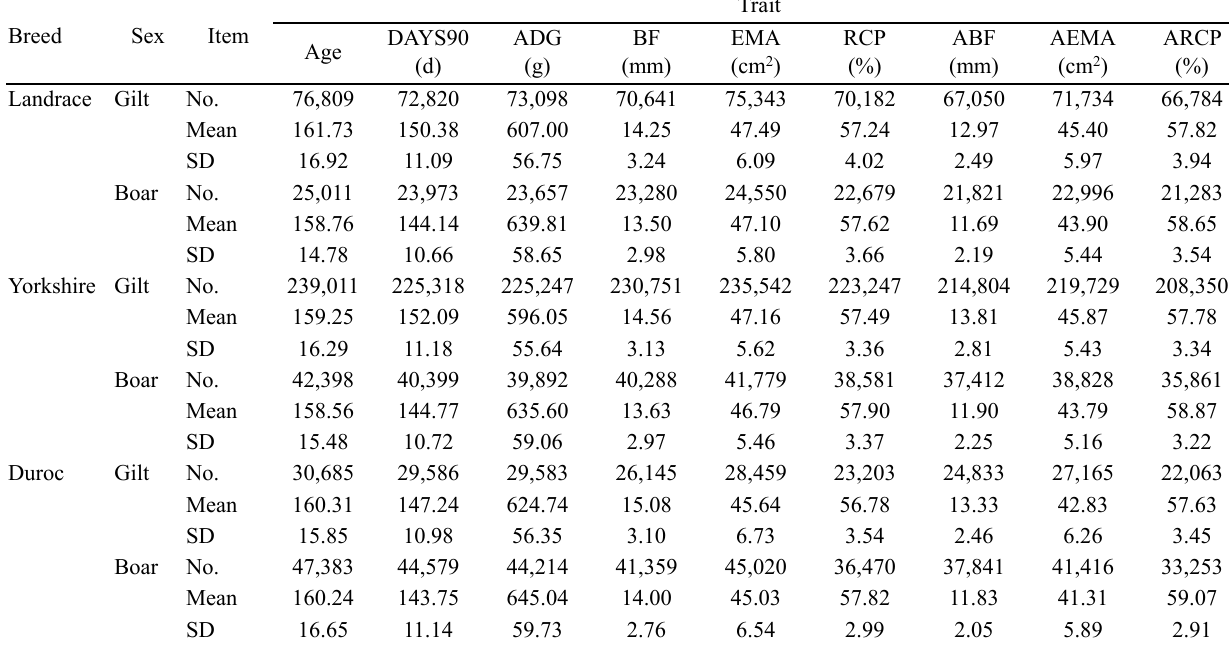
Table 3. Summary statistics on the performance records by breeds